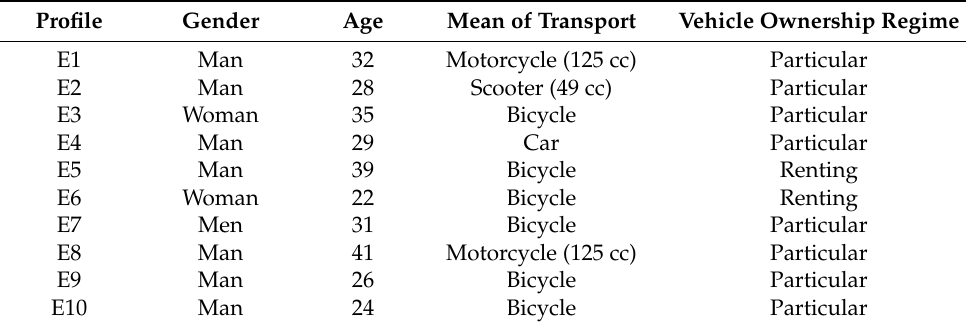
Table 1. List of fieldwork participants.